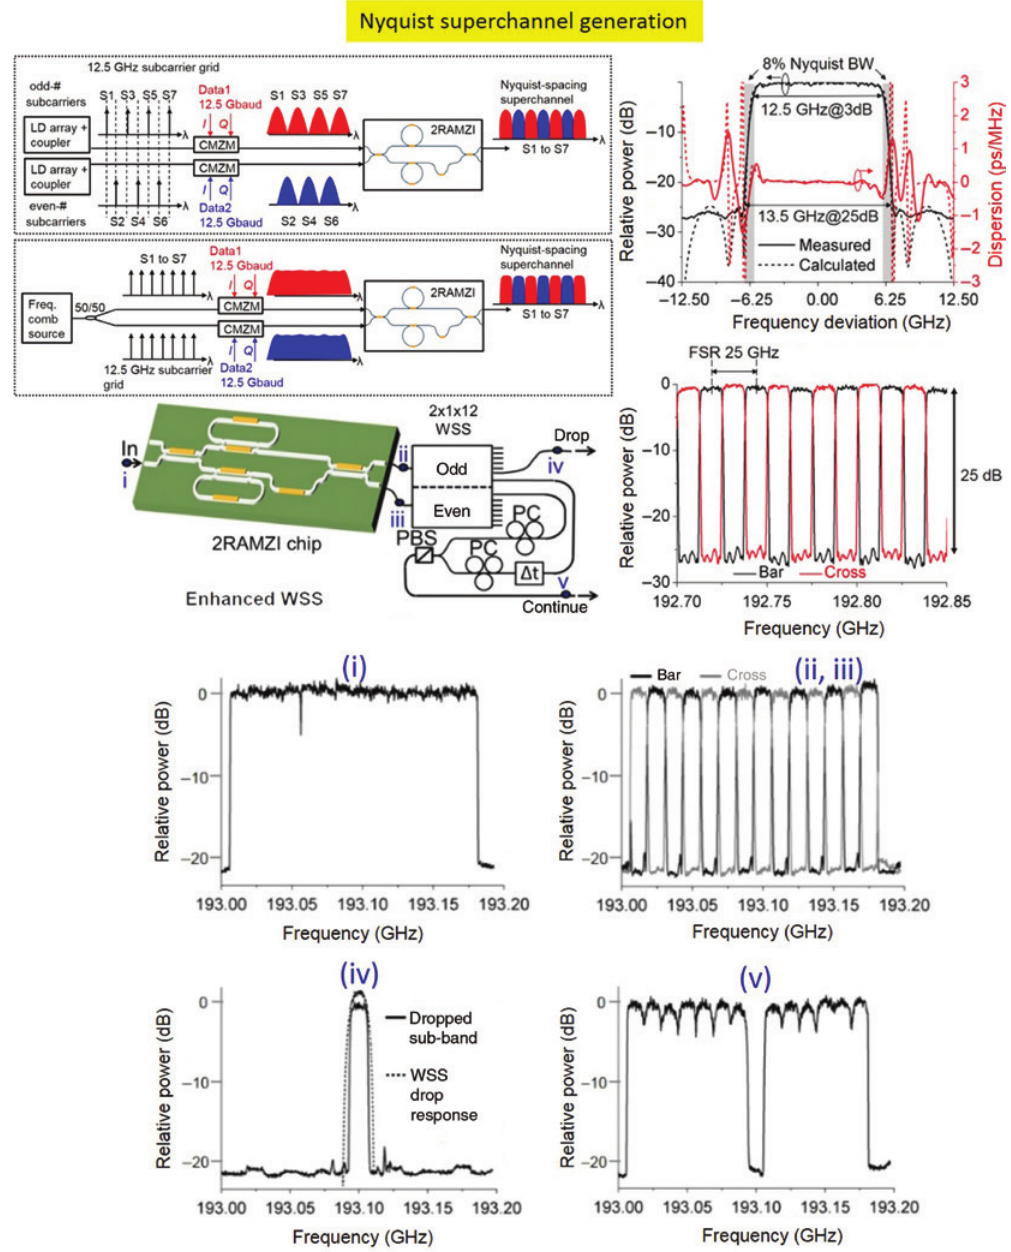
Figure 14: Design and realization of a highly reconfigurable RAMZI circuit: an application as a Nyquist-filtering interleaver for WDM super- channel multiplexing and demultiplexing [55] (Copyright in 2016, Optical Society of